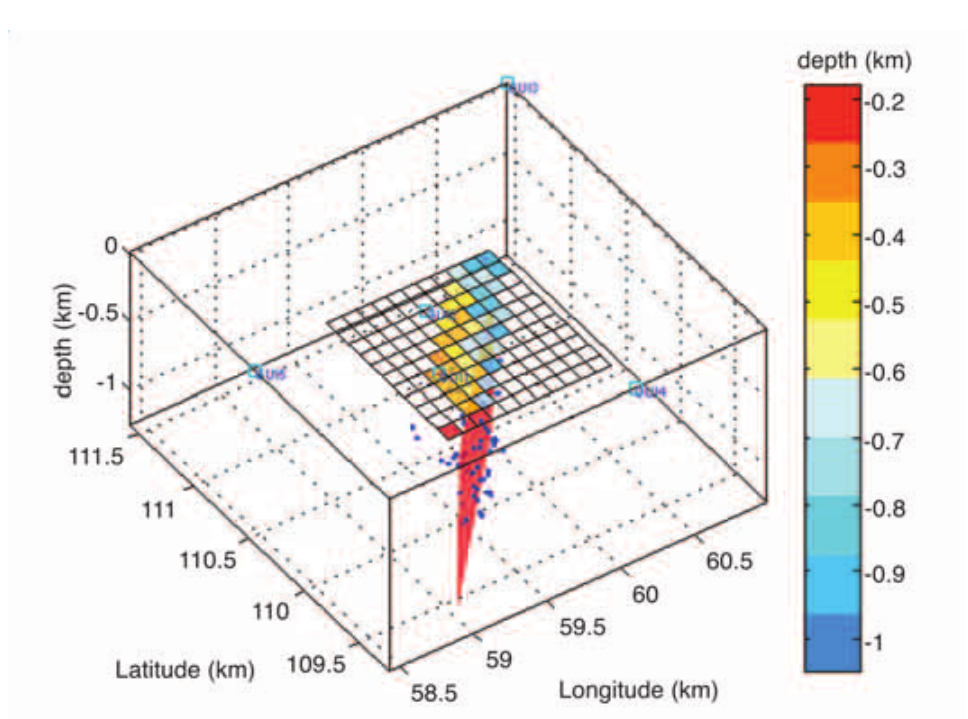
Fig. 10. Three-dimensional hypocentral locations with the stations of the local network; the horizontal plane indicates the depth of the